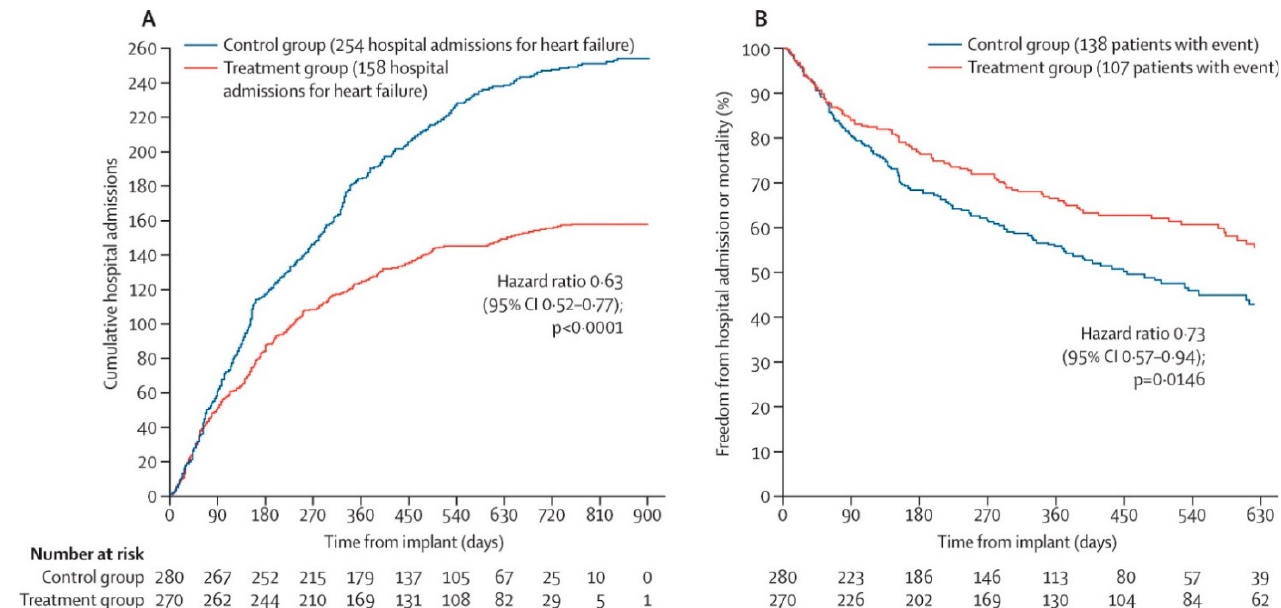
Figure 2. Short-term results from the CHAMPION trial: Cumulative heart-failure-related hospitalizations during entire period of randomized single-blind follow-up ( A ), and freedom from first heart-failure-related hospitalization or mortality during the entire period of randomized follow-up ( B ). Reprinted from The Lancet Volume 377, Issue 9766, Abraham et al., Wireless pulmonary artery hemodynamic monitoring in chronic heart failure: a randomized controlled trial, pages 658–666, Copyright 2011, with permission from Elsevier [4].